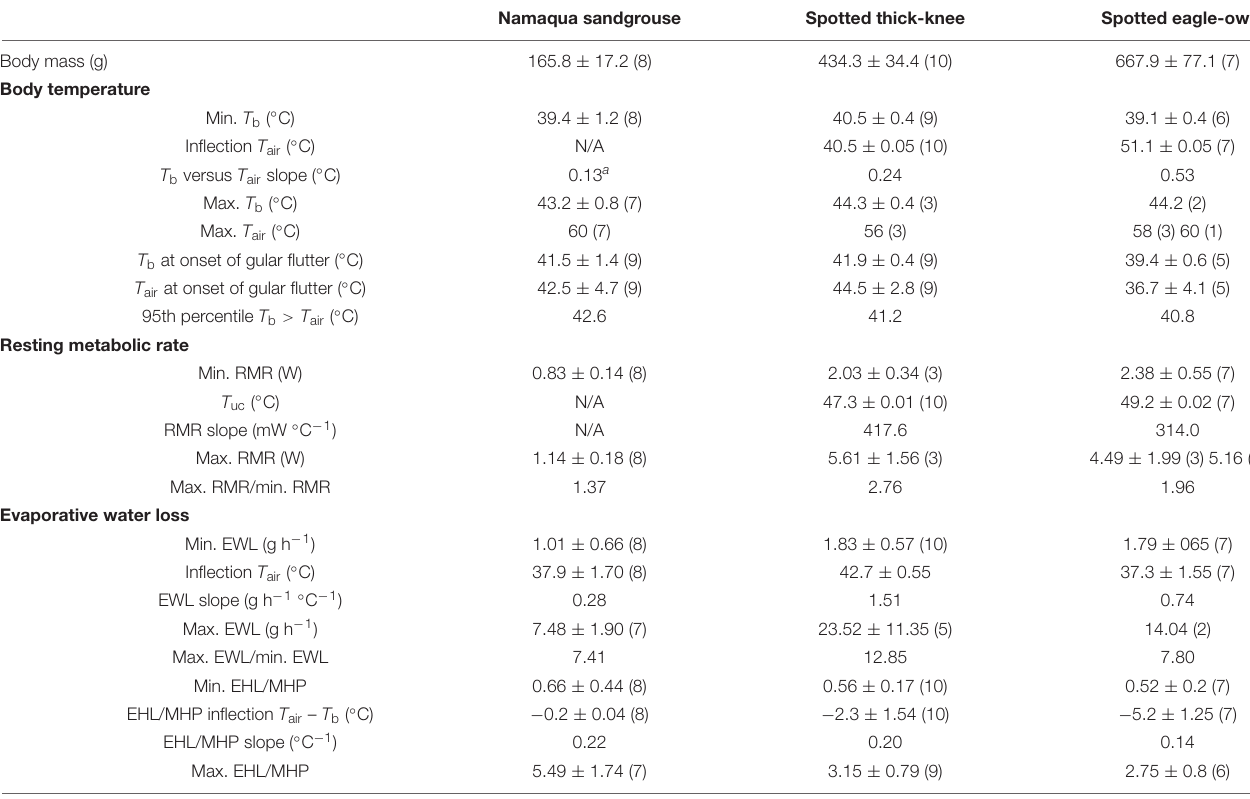
TABLE 2 | Variables related to interactions between body temperature, metabolic heat production and evaporative heat dissipation as functions of air temperature in three species from the arid zone of southern Africa, quantified using flow-through respirometry: Namaqua sandgrouse ( Pterocles namaqua ), spotted thick-knees ( Burhinus capensis ) and spotted eagle-owls ( Bubo africanus